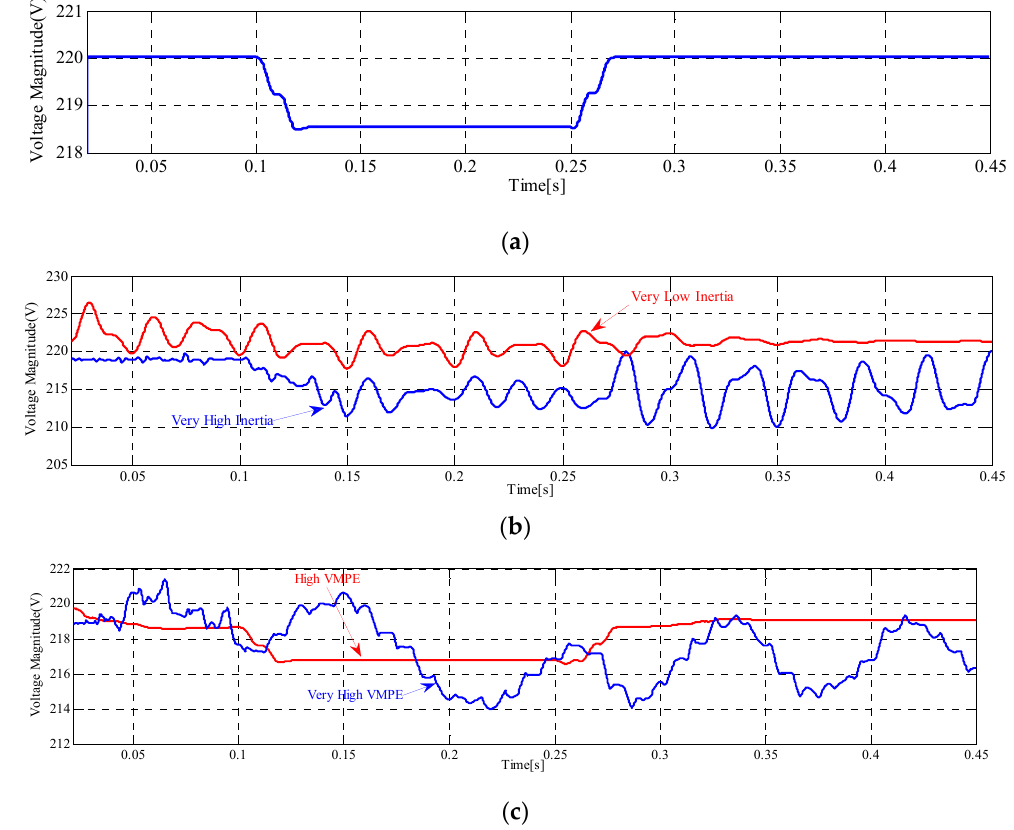
Figure 12. The grid voltage magnitude under ( a ) appropriate virtual inertia and VMPE, ( b ) very high and low virtual inertia, and ( c ) high and very high values of VMPE.